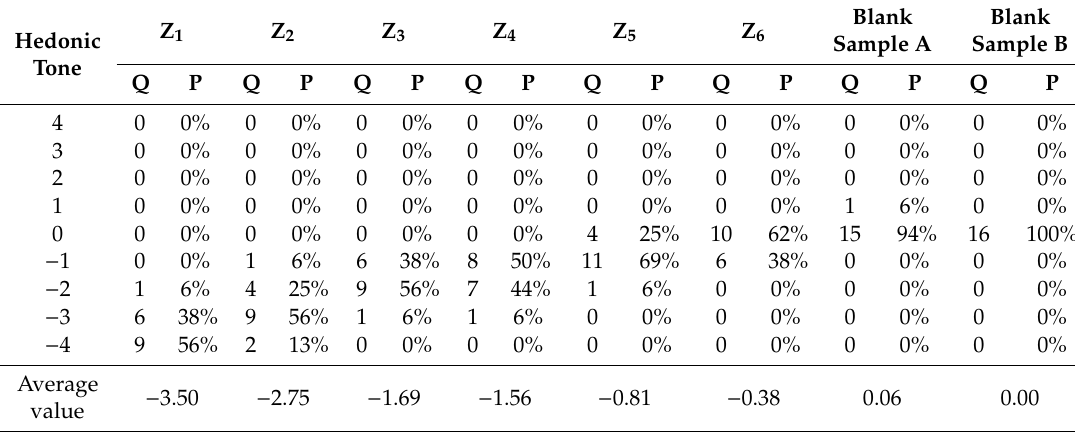
Table 2. The result of the hedonic tone evaluation for dimethyl disulfide; the odor concentration, OC of the original sample is 7413 OU E · m − 3 . The dilution times from Z 1 to Z 6 are respectively 10, 30, 100, 300, 1000 and 3000. Q: amount of people; P: proportion of the population.